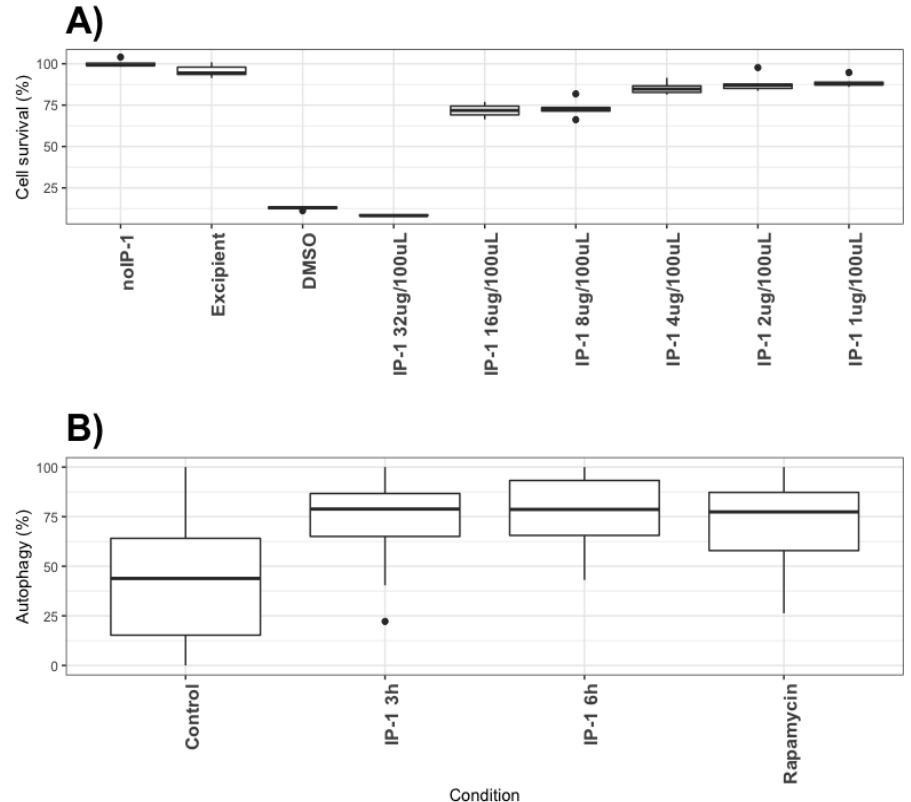
Figure 4. Cytotoxicity and autophagy induction of IP-1 on macrophages. Top panel: ( A ) Percentage of macrophages (J774.1) staining with violet dye, as an indicator of cell survival (see Materials and Methods section). noIP-1 and Excipient shows percentage of staining on cells without IP-1; DMSO is a toxic agent to macrophages and serves as positive control for dead cells; di ff erent concentrations of IP-1 were used (1, 2, 4, 8, 16, and 32 µ M) to test for the survival of macrophages. The data were derived from at least 3 to 6 independent experiments. Bottom panel: ( B ) The percentage of cells showing green dots as indicative of autophagy as detected by Cyto-ID (see Materials and Methods section). Control are cells not exposed to IP-1, Rapamycin show the results of cells exposed to the autophagy-inducer rapamycin, and the autophagy detected at 3 and 6 h in the presence of IP-1 are shown. These data were derived from at least 30 photographs obtained from 3 independent experiments. The statistical comparison between groups was performed using ANOVA test and the p -values were obtained from a Post-hoc analysis with Tukey test (see [34]). The black circles represent outliers.